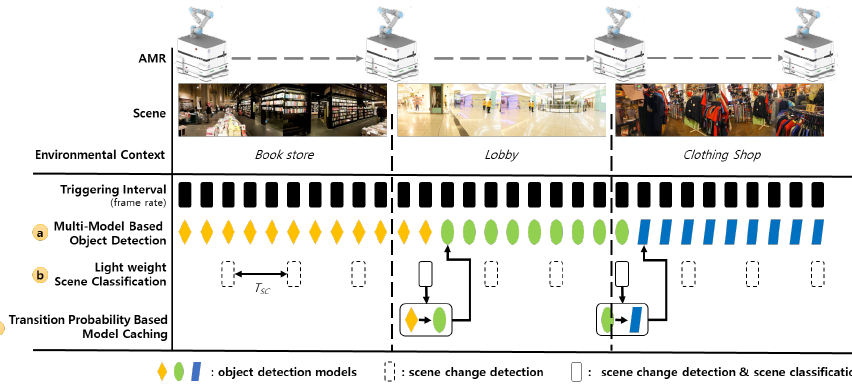
Figure 3. Overall process of M-ODF.